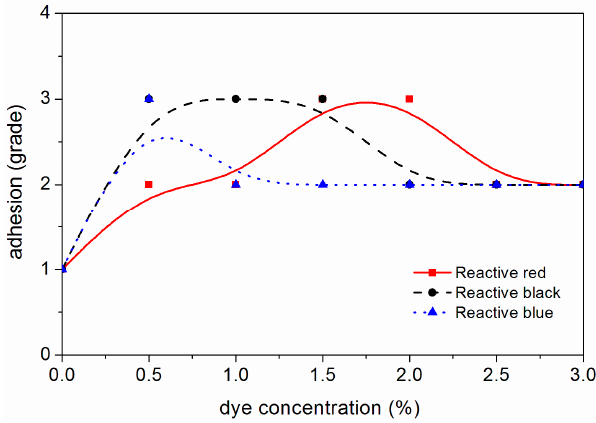
Figure 8. Variation trend of waterborne coating hardness on the F. mandshurica veneer after dyeing.